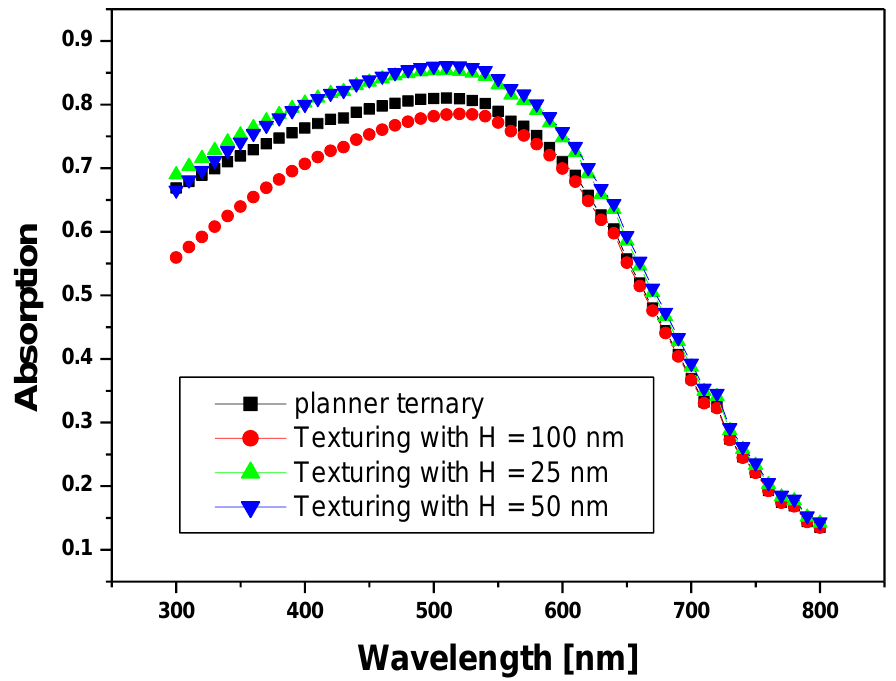
Figure 4. Hydrogenated amorphous silicon solar cell (a-Si: H) absorption spectrum with ternary anti-reflective coating with texturing on the top surface with different heights as shown. The ternary ARC is composed of silicon nitride with a thickness of 33 nm immersed between silicon dioxide and titanium dioxide with a thickness of 54 nm and 82 nm, respectively.